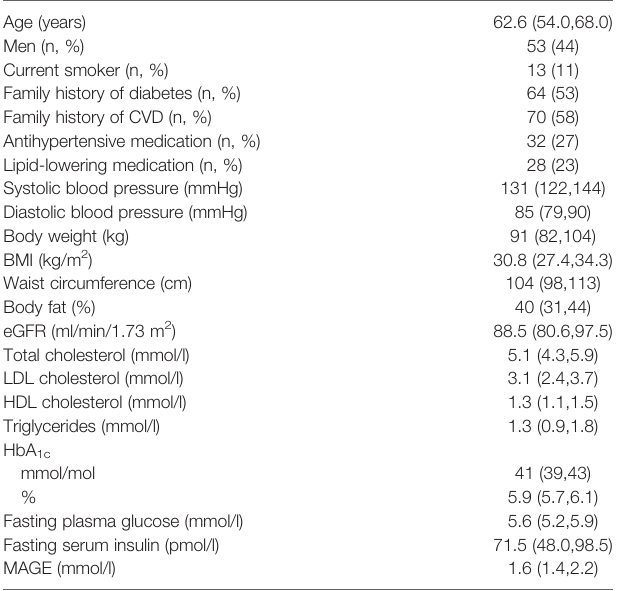
TABLE 1 | Characteristics of study participants at baseline (n = 120).